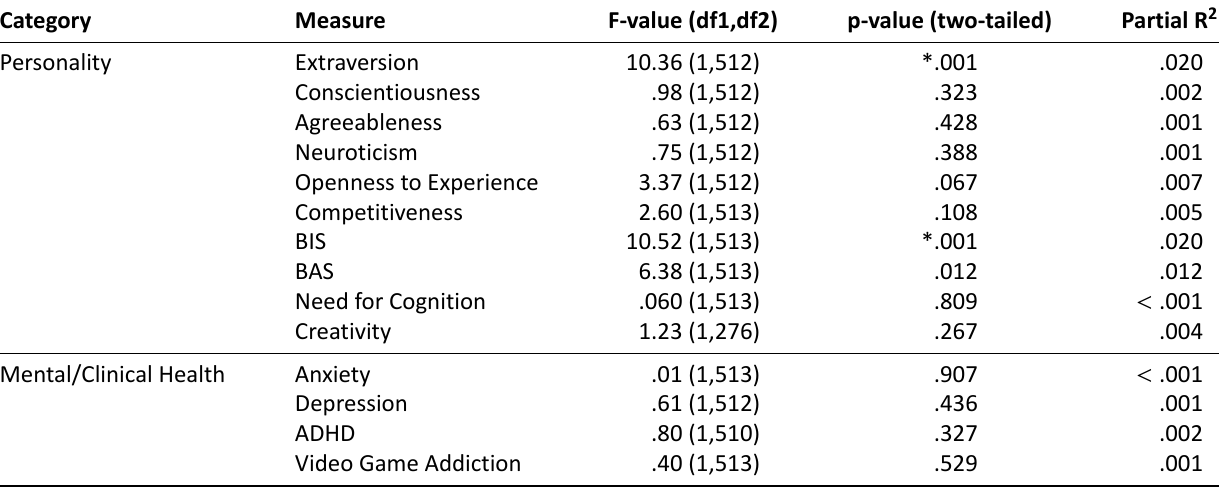
Table A5. Regression values between League of Legends MMR and behavioral factors. Category